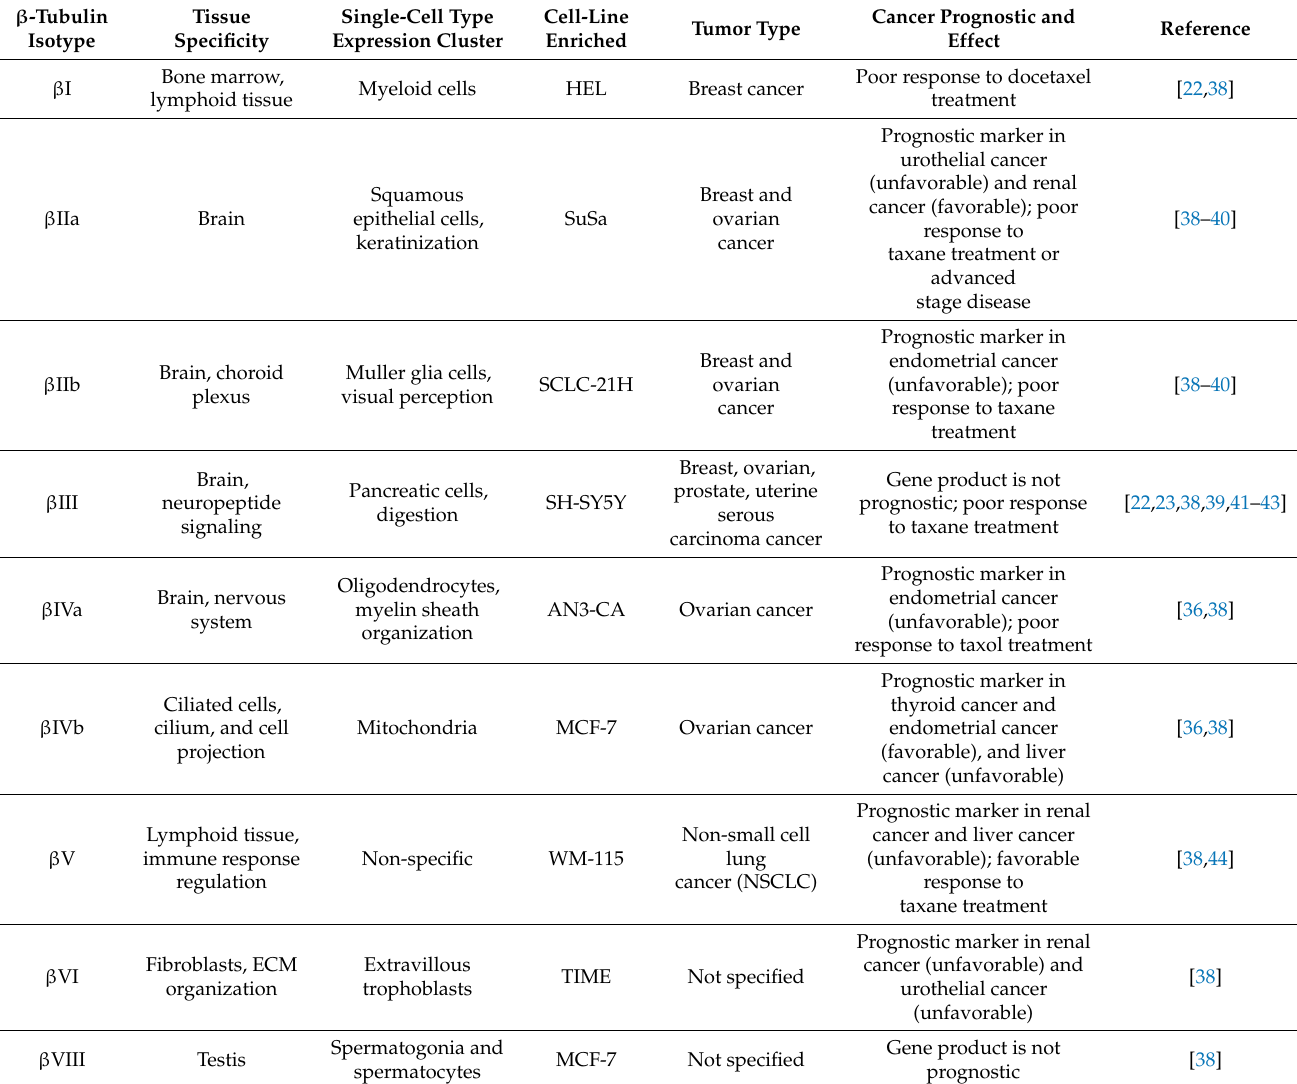
Table 7. Clinical studies of β -tubulin isotypes in cancer